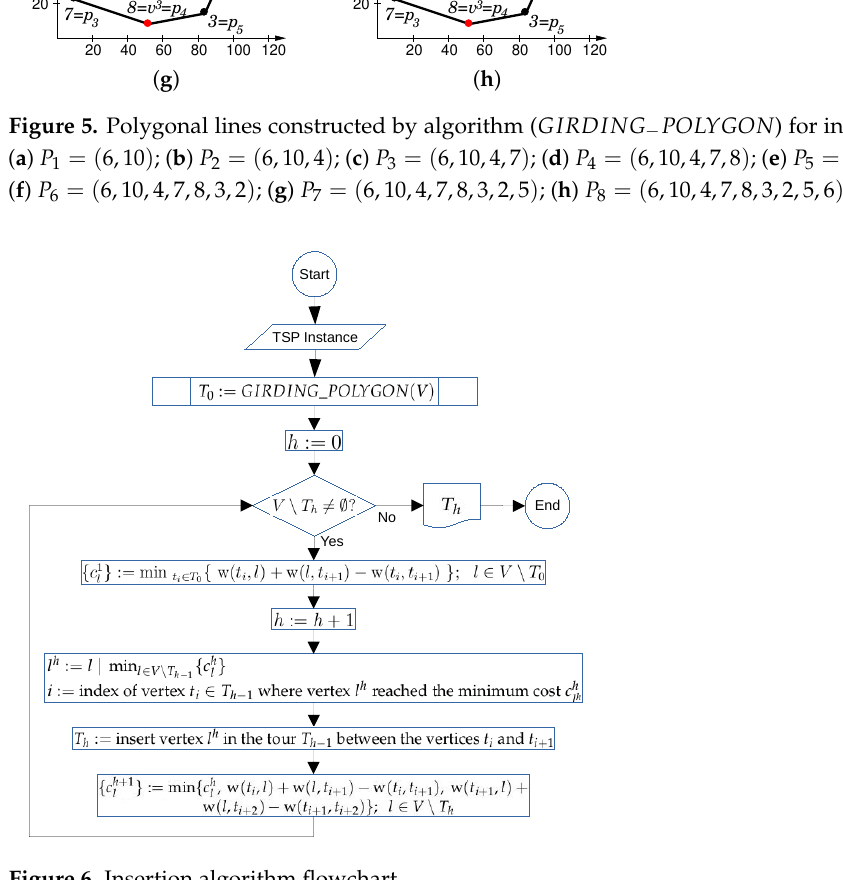
Figure 6. Insertion algorithm